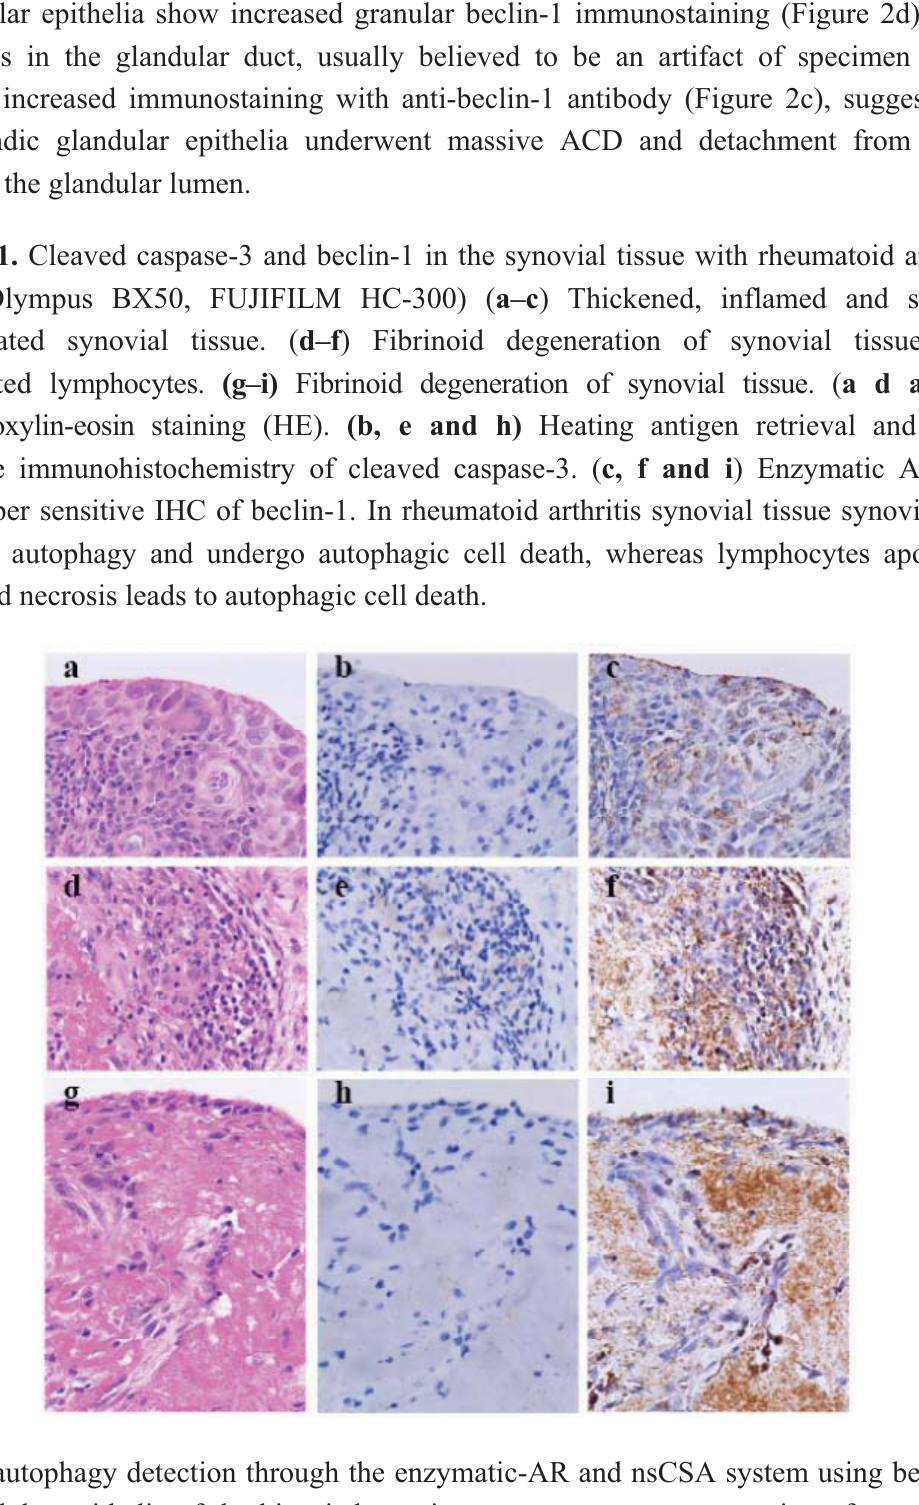
Figure 1. Cleaved caspase-3 and beclin-1 in the synovial tissue with rheumatoid